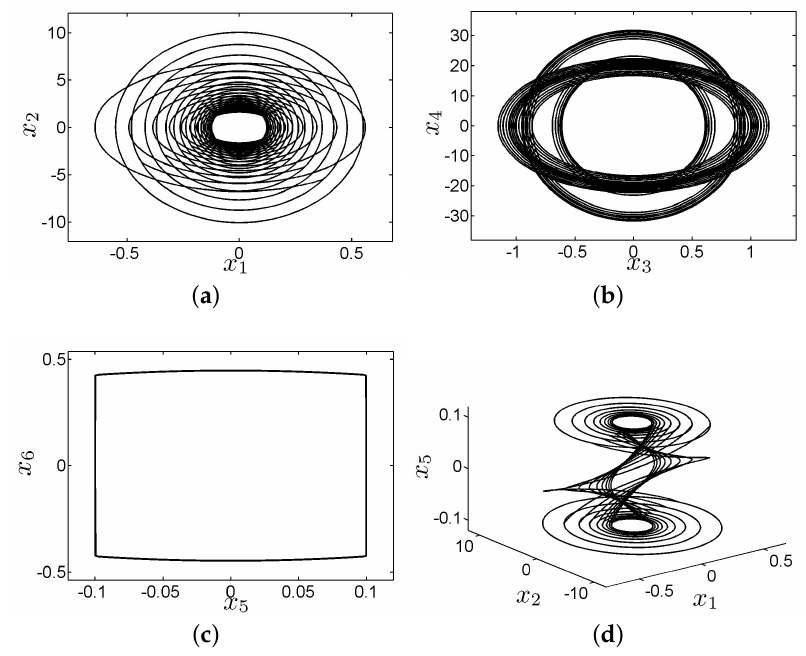
Figure 8. System response in three directions ( L = 515m). ( a ) The axial phase diagram. ( b ) The torsional phase diagram. ( c ) The lateral phase diagram. ( d ) Phase diagram in three directions.